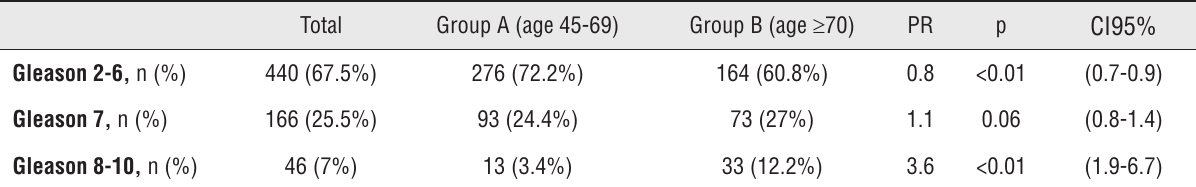
Table 2 - Gleason score from